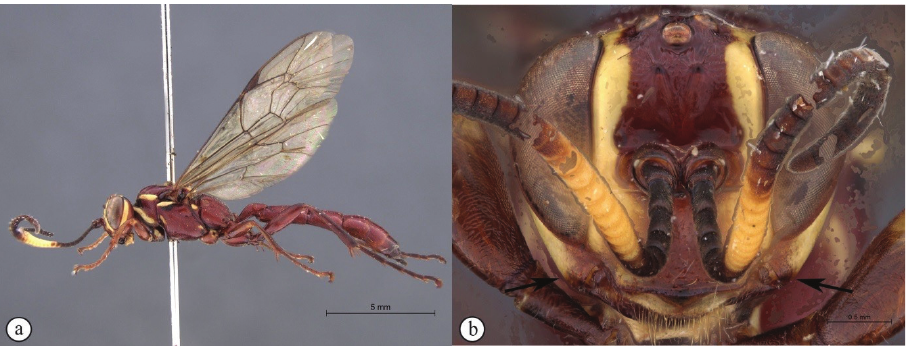
– General coloration dark red (a); lower gena not expanded (b)